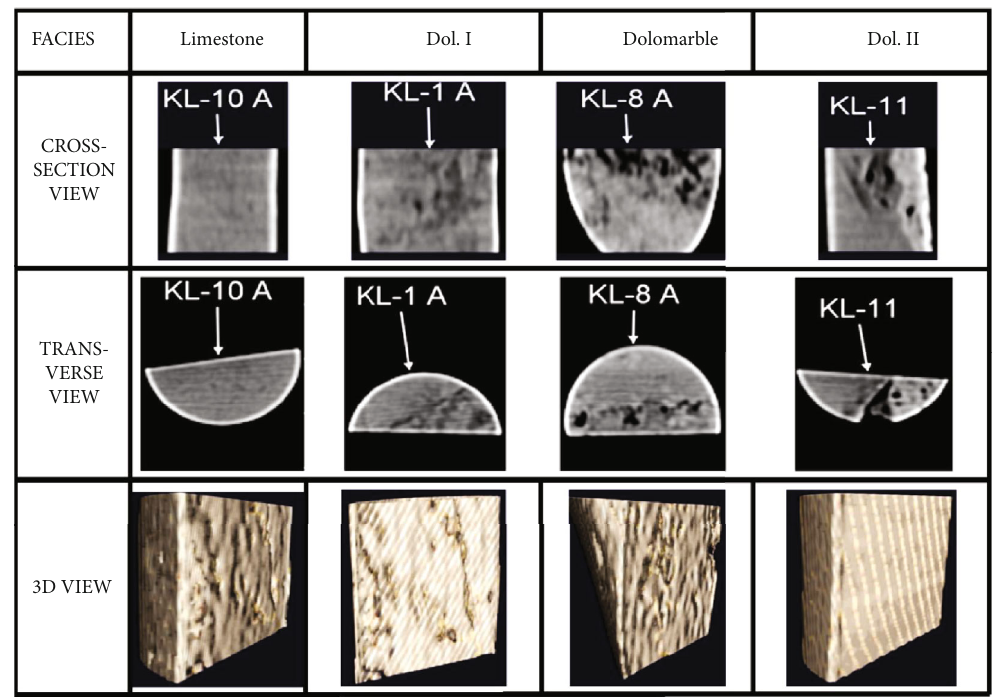
Figure 11: Computed tomographic (CT) studies of the selected plug samples representing various diagenetic phases. The fi rst and second rows show the cross-sectional and transverse view of the CT studies. Note that the black spots indicating porosity are signi fi cantly higher in the dolomitic marble and Dol. II. The third row shows the 3D view of the selected samples, indicating pore network and their connectivity.